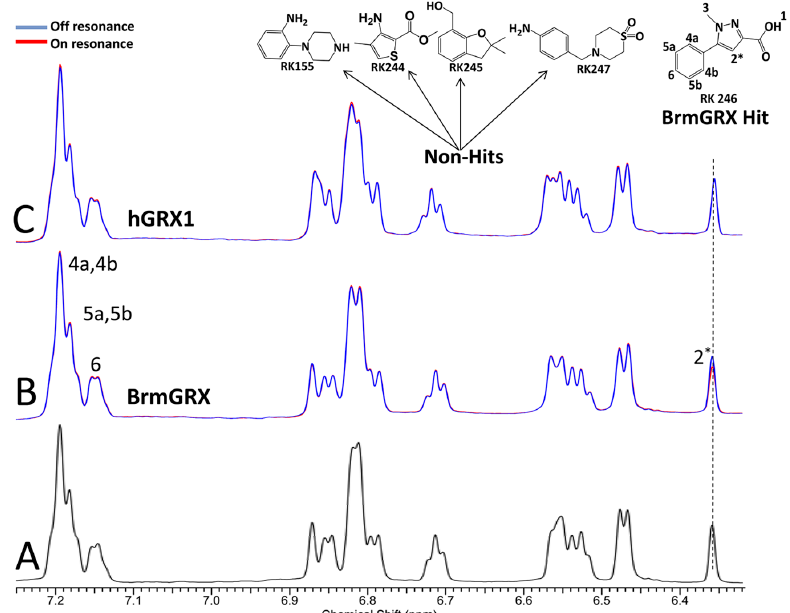
Figure 3. On- and off-resonance STD spectra for a fragment pool containing RK246 against two orthologous proteins. ( A ) The normal 1 H-NMR spectrum for the fragment pool; ( B ) Shows the STD spectra for the fragment pool with BrmGRX and ( C ) is the STD spectra for the fragment pool with hGRX1. These are collected at 750 MHz with a cold probe at 0.5 mM fragment and 10 μ M protein. Selective hits obtained from primary STD screening were further validated beginning with transfer Nuclear Overhauser Effect (trNOE) spectroscopy. The principle of trNOE is that transfer of cross-relaxation between protons can be measured between bound and unbound fragments; this is influenced by the large correlation time of the ligand-target complex via chemical exchange [21]. Upon ligand binding to protein, a large negative NOE in trNOE spectrum is observed [20]. 6% of STD-selective hits for both GRX orthologs were found to show negative NOE peaks in the trNOE spectra, thus doubly confirming some of the STD selective hits to be unique binders with their respective GRX ortholog. Mixtures of hit fragments were used in order to reduce the number of spectra collected (both to conserve NMR time and d 8 glycerol) and to allow for possible observation of interligand NOEs (iLOEs) useful for the process of linking and merging fagments. These were not considered in the present system but could be used in future fragment growing/linking campaigns.